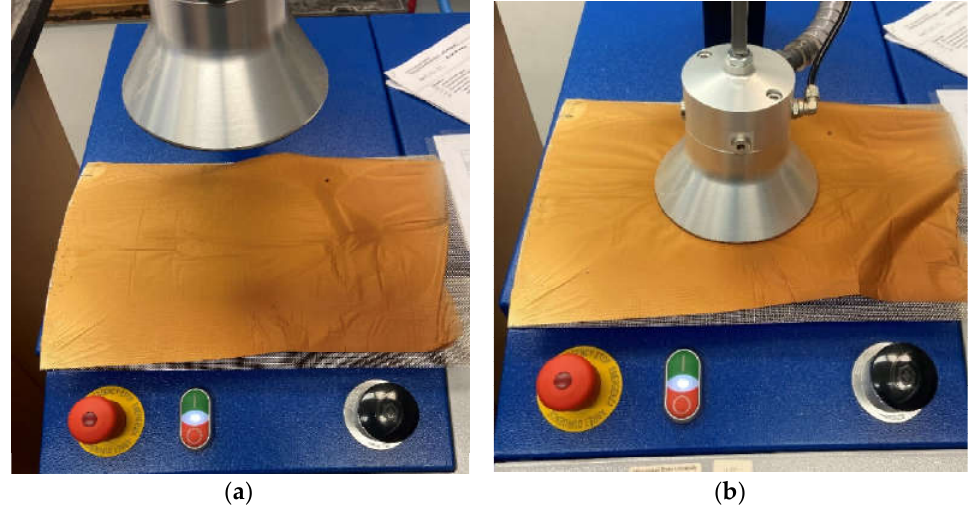
Figure 12. Air filtration testing of trial #3. ( a ) TSI8130A test machine setup and preparation. ( b ) Air filtration test in progress.